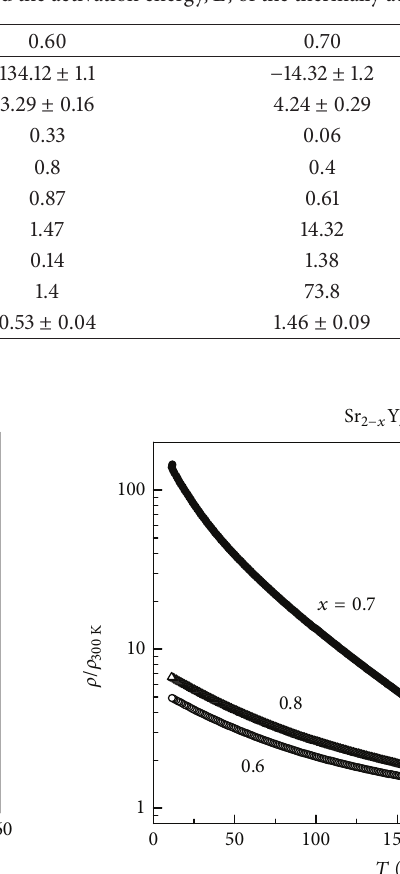
Figure 5: The normalized resistivity ( 𝜌/𝜌 300